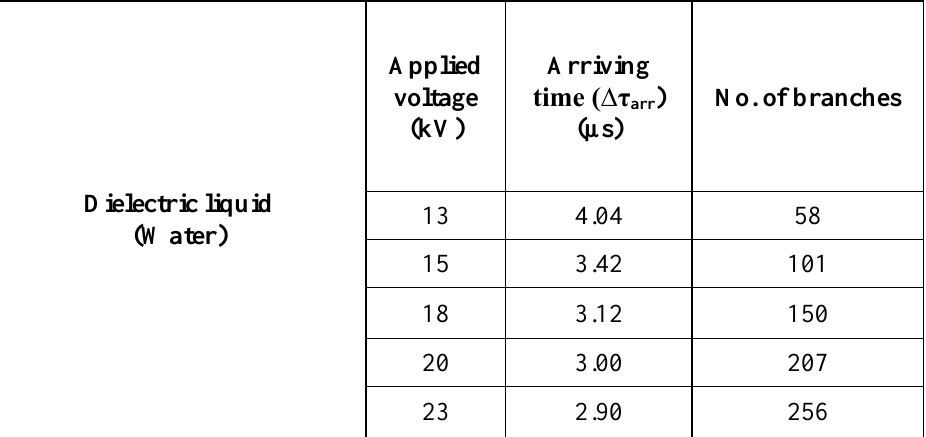
Fig. 6: The propagation and branched structures of streamers (at each time step) for different applied voltage within pin - plane arrangement. Table 1: The arriving time and the number of branches at each applied